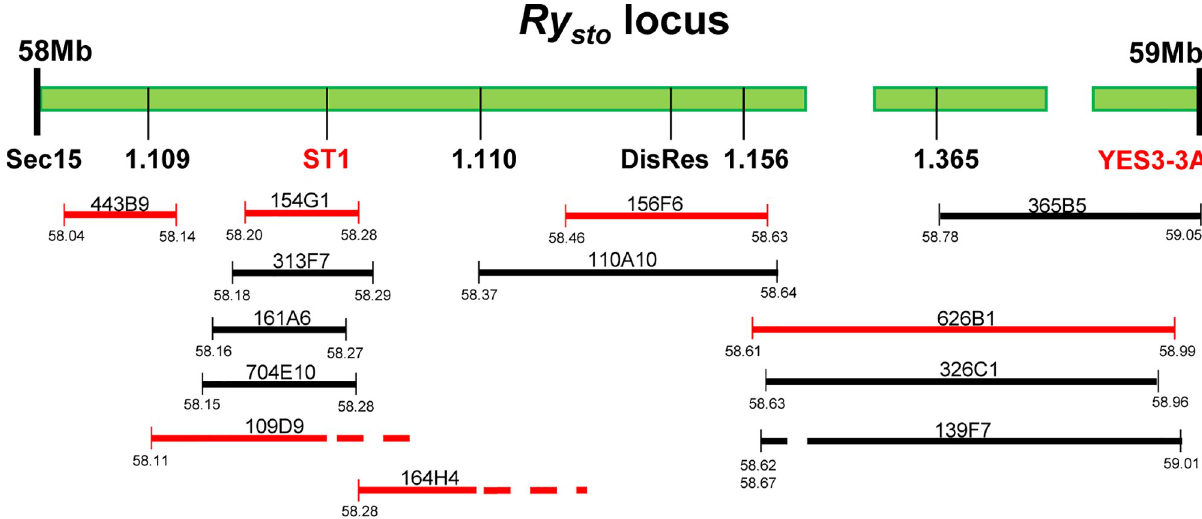
Fig 3. Physical map of the Ry locus with the overlapping BAC clones. The Ry locus in the S . tuberosum cv. ‘White Lady’ corresponds to the 58- sto sto 59-Mb region on chromosome XII in the genome-sequenced S . tuberosum Group Phureja DM1-3 516R44. This region of Phureja has sequence gaps probably due to its highly repetitive nature. Markers used for genetic mapping and isolation of BAC clones are indicated under the upper line illustrating the chromosomal fragment. BAC clones are represented by the horizontal lines with their names on them. The published markers and the fully sequenced BAC clones are highlighted in red. The numbers under the lines indicate the position of the BAC ends on the corresponding Phureja genome sequence. The position of BAC ends indicated by dashed lines could not be defined precisely because these segments possess a large number of repeated